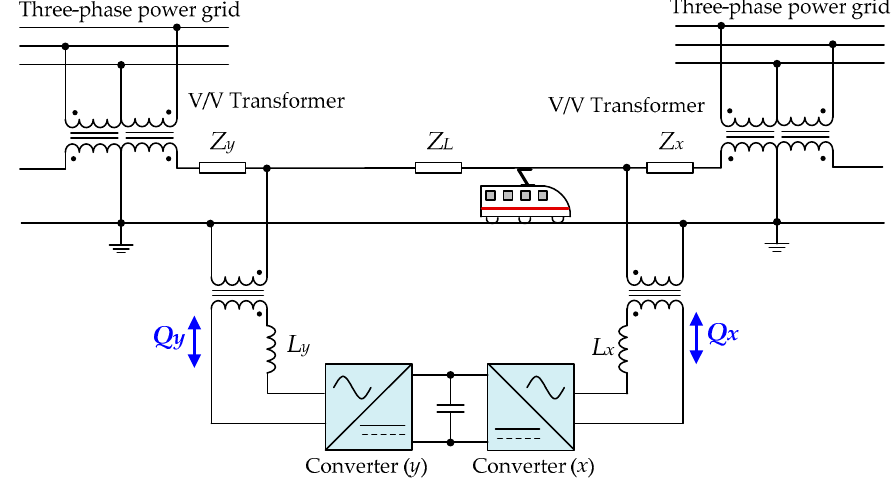
Table 2. Capabilities of the RPC operating in catenary voltage regulator mode.